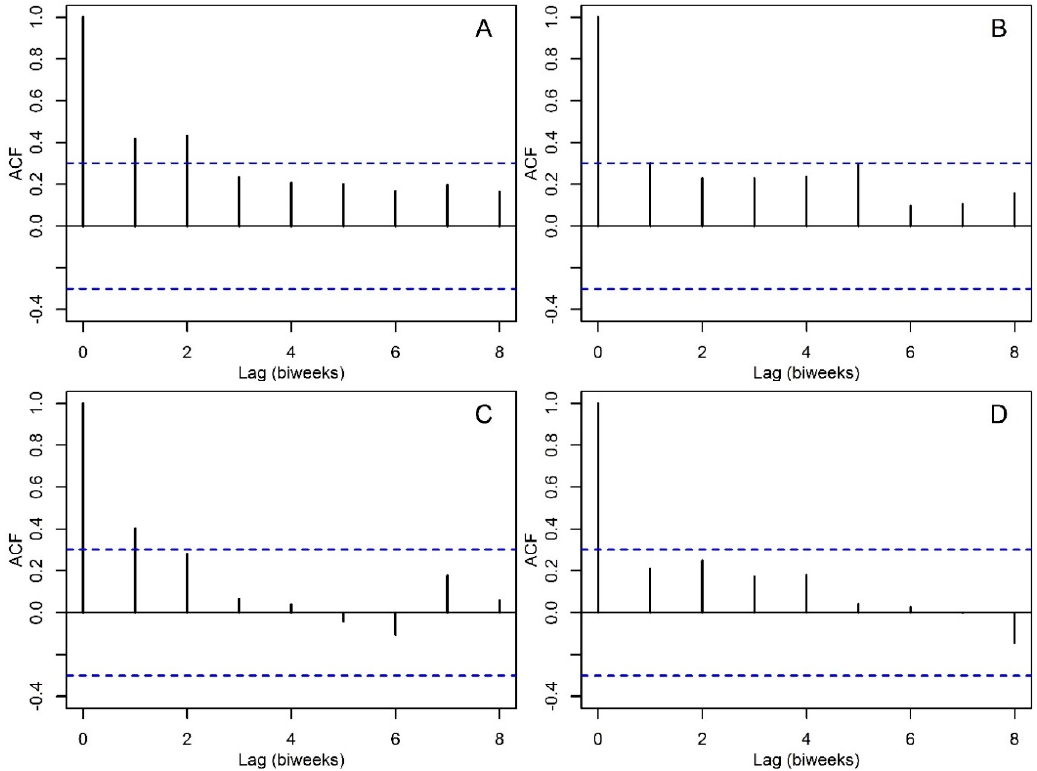
Figure 4. Autocorrelation functions (ACF) Aedes aegypti per BG Sentinel trap collection in ( A ) Sanmin and ( B ) Nanzih. Culex quinquefasciatus per BG Sentinel trap collection in ( C ) Sanmin and ( D ) Nanzih. In the panels, dashed blue lines are 95% confidence limits within which correlations are expected to occur by chance.